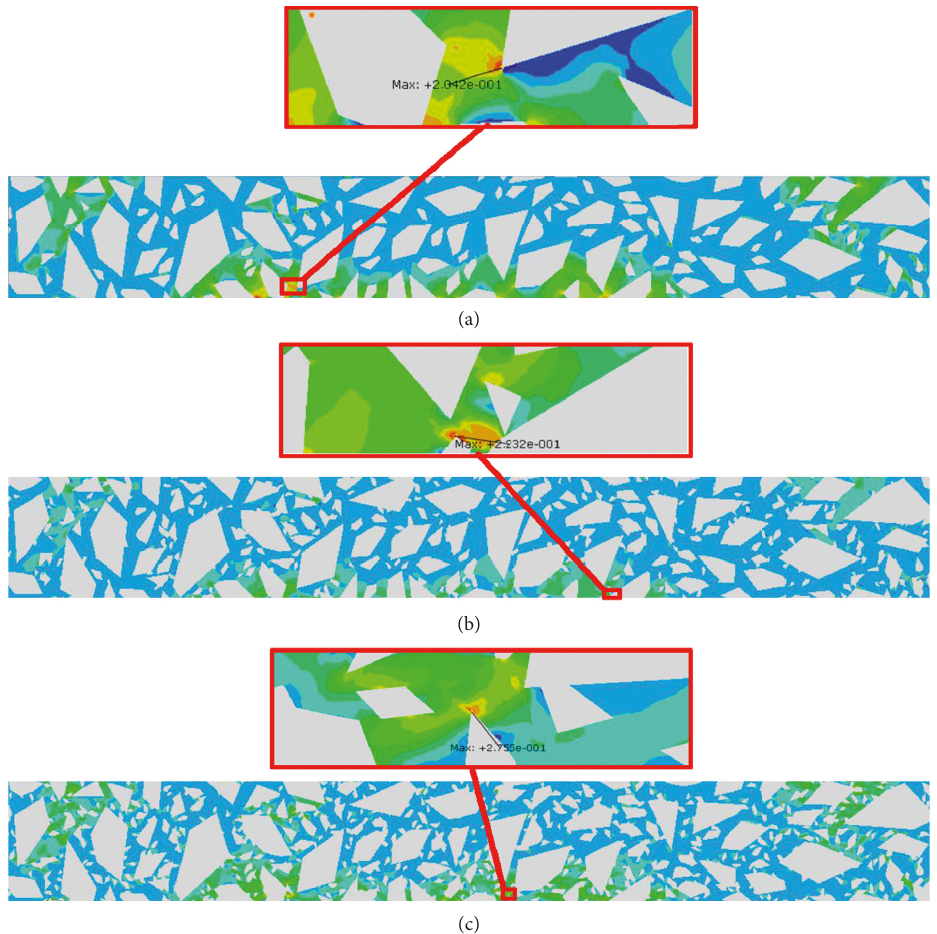
Figure 13: Influences of the voids on the fatigue damage of asphalt mixtures: (a) 0% VV; (b) 4% VV; (c) 8% VV.